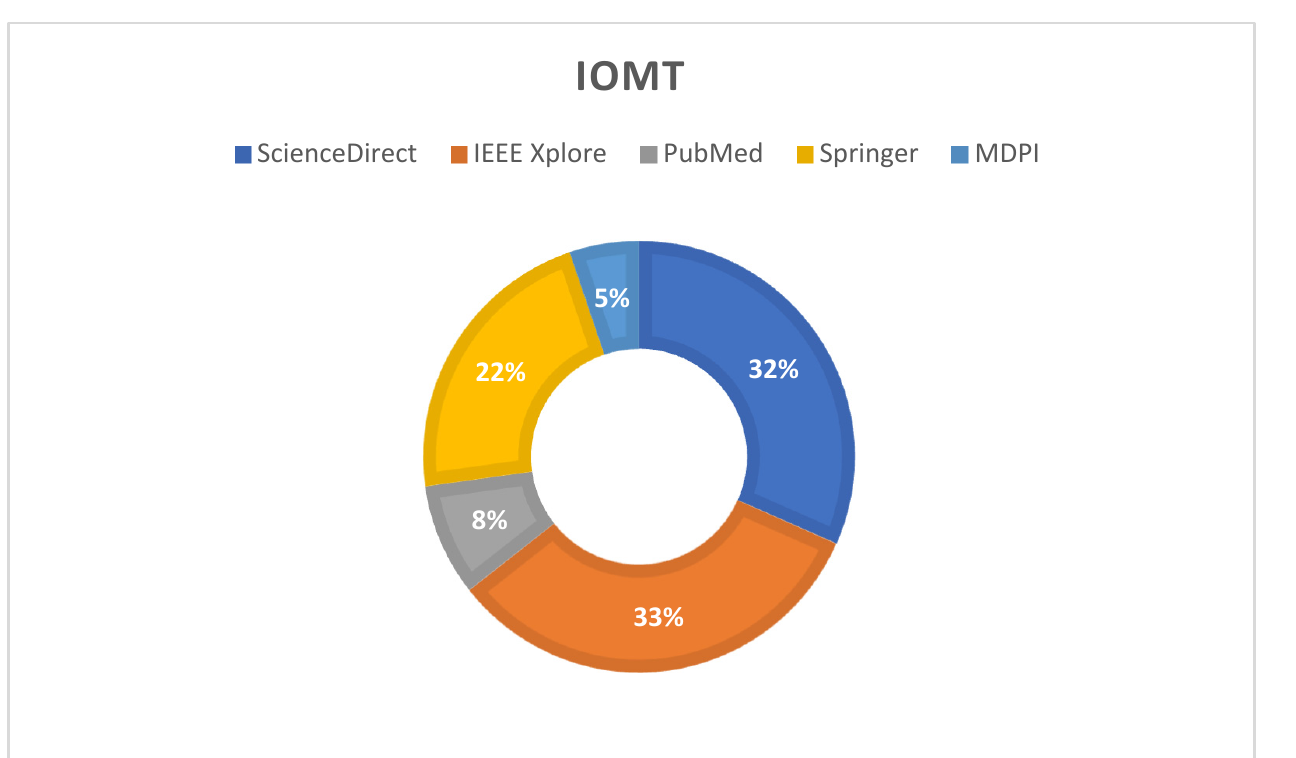
Figure 9. Search result for term IoMT.